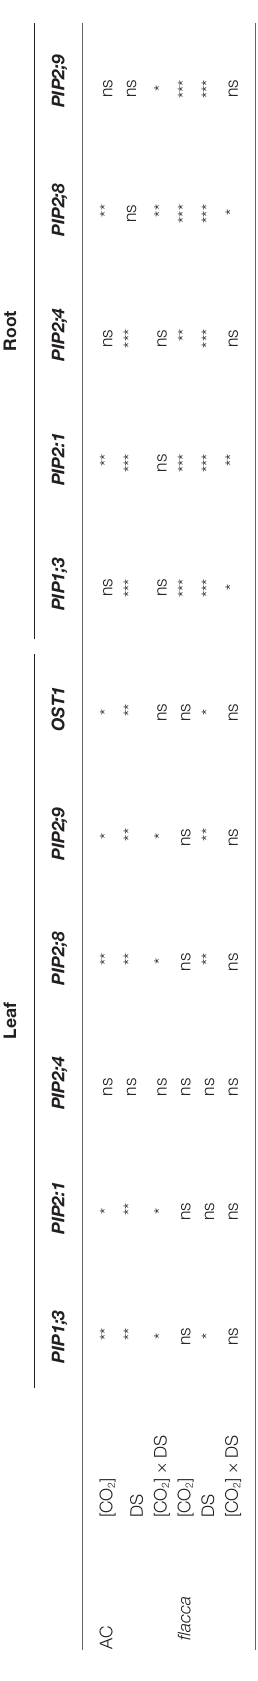
treatments are separated on each side of the plot only in